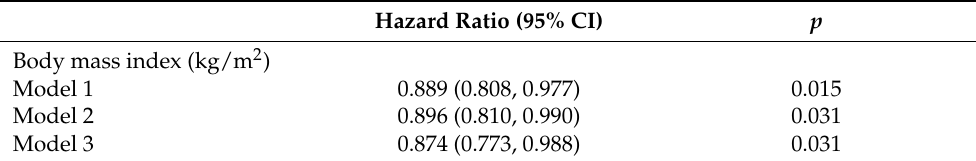
Table 3. Effect of body mass index (as a continuous variable) on all-cause mortality.